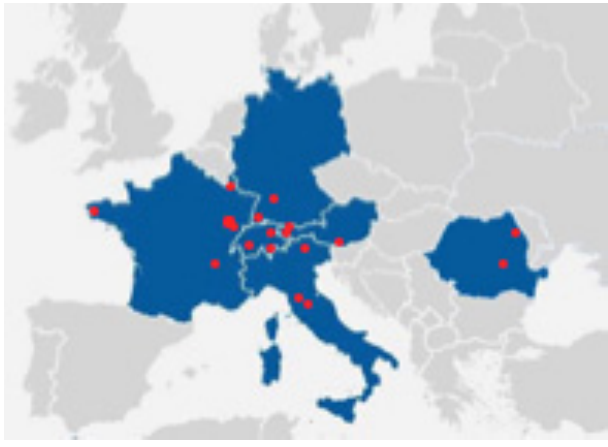
Figure 3. Map of the participant